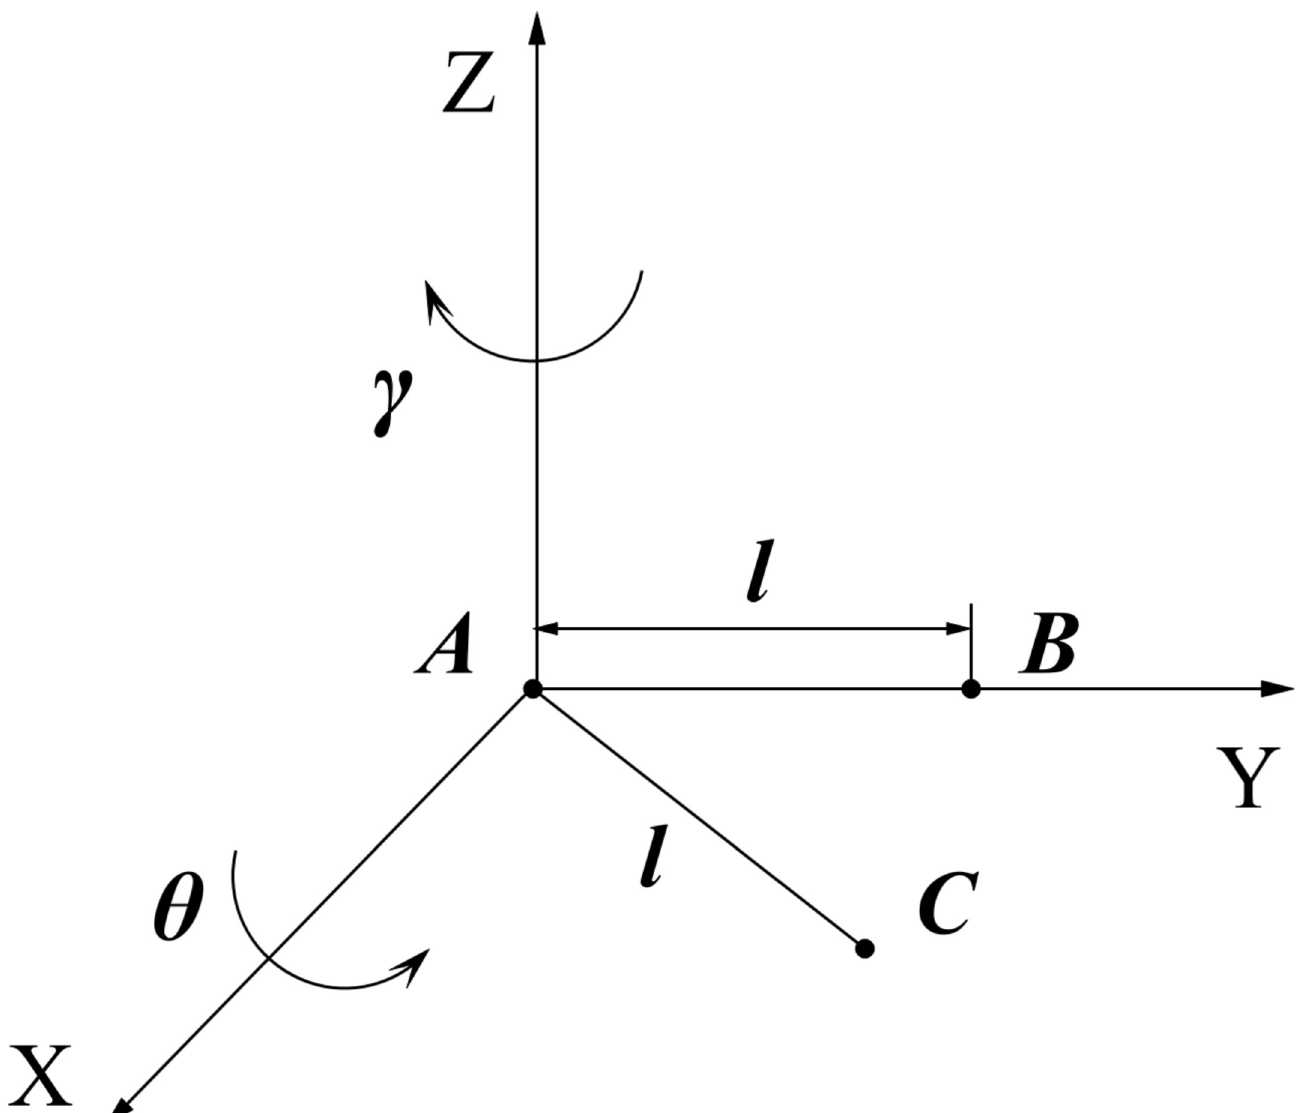
Fig 12. Root growth